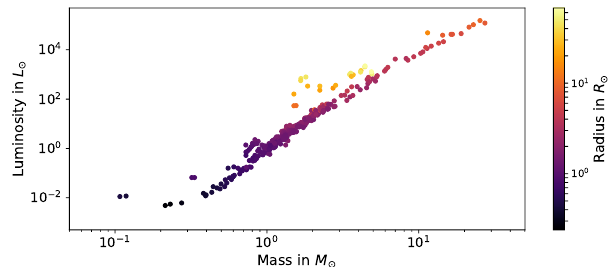
Fig. 32.— Mass-luminosity diagram with data points plotted using an artificial color map that indicates the stars’ radii. Data from DEBCat grow along the main sequence, but the red giants, in their little cloud of data points above the main sequence, are larger